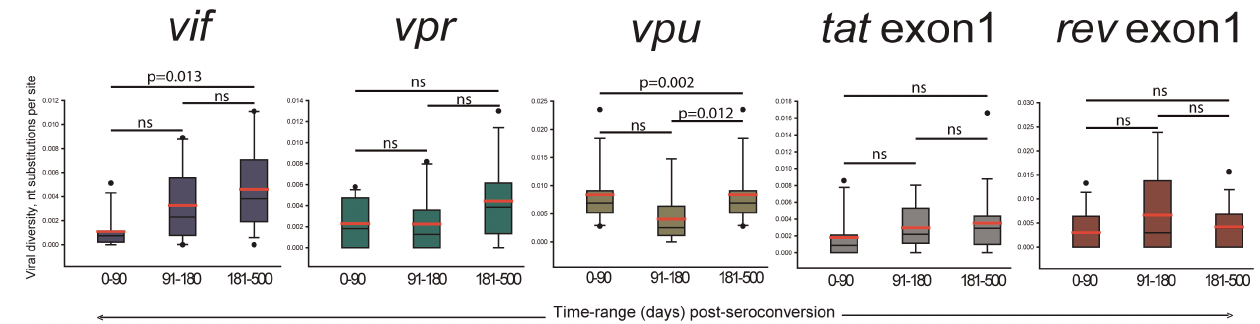
Figure 3. Individual distribution of pairwise distances for each of the non-stuctural genes, vif (HXB2 start 5041 to 5619), vpr (HXB2 start 5559 to 5850), vpu (HXB2 start 6062 to 6310), tat exon 1 (HXB2 start 5831 to 6045), and rev exon 1(HXB2 start 5970 to 6045).